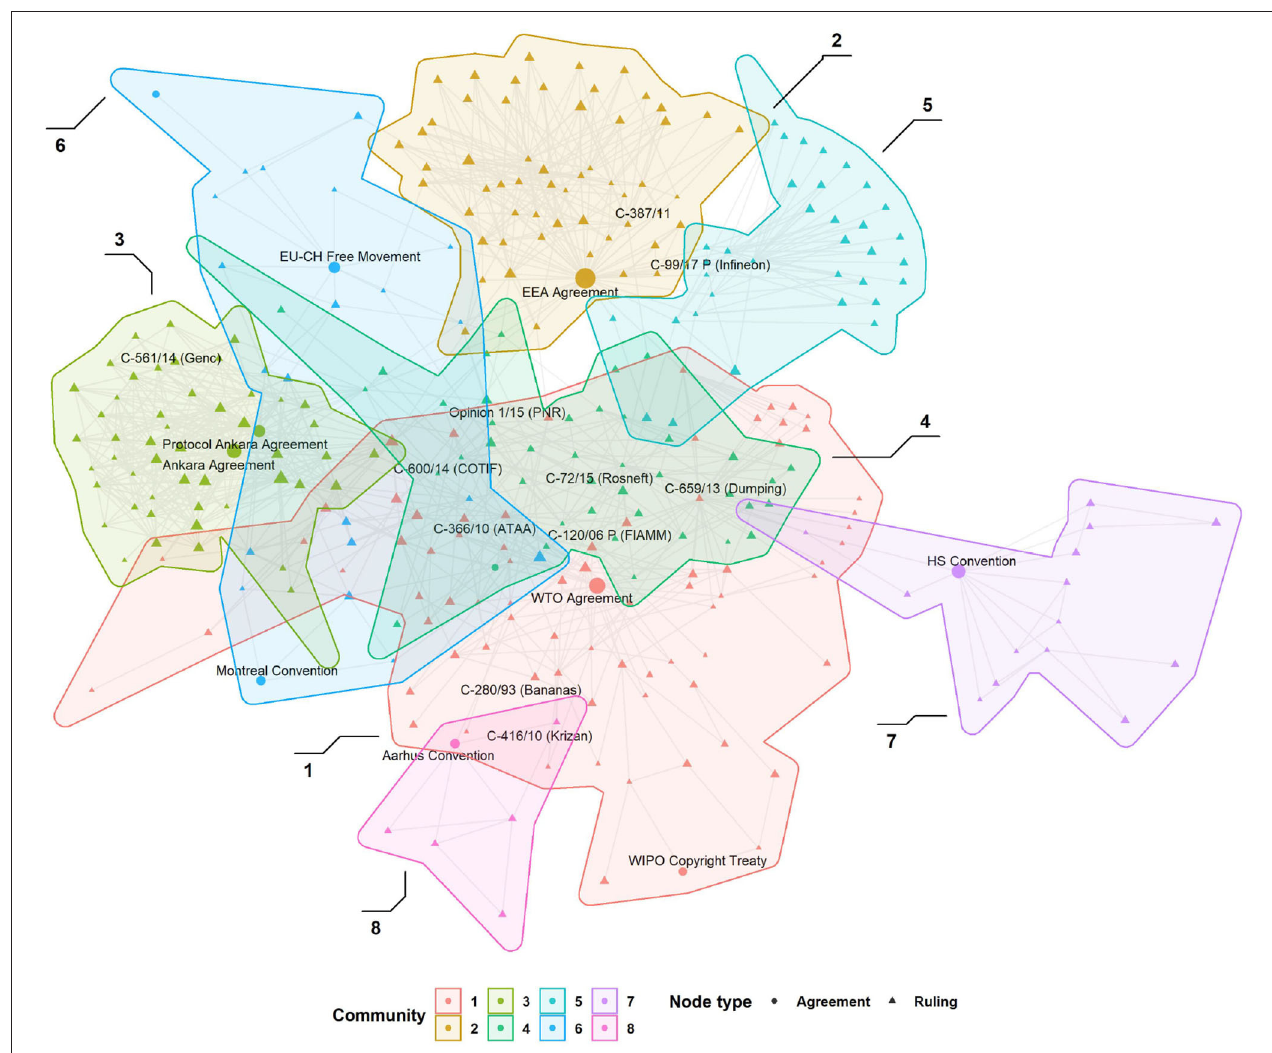
FIGURE 5 | Most influential agreements and rulings. The network shows only nodes with above average Eigen centrality. Node size reflects in-degree centrality. Colored areas, labeled from 1 to 8, represent network communities as identified by Newman’s [ 24] fast-greedy